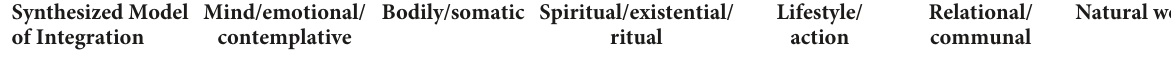
TABLE 1 Comparison of integration models with resulting synthesized model of